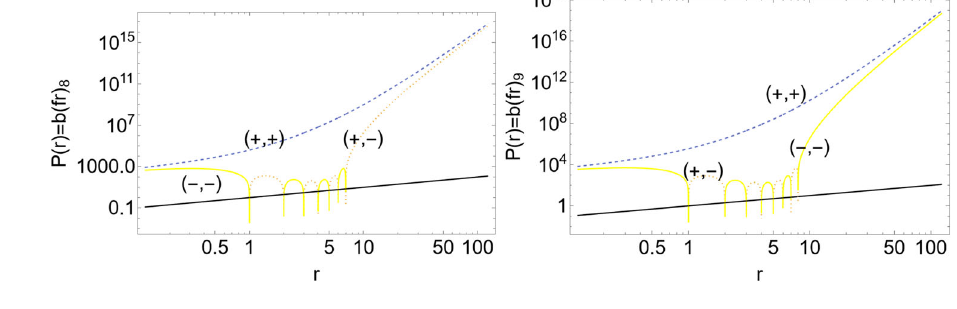
Fig. 17 Pochhammer symbol P ( r ) ≡ b ( f r ) y as function of r (where M = 1) for different values of ( b , f ) , signed on the curves, and for y even (left panel) and y odd (right panel). The black line is P ( r ) ≡ b ( f r ) y = r (for